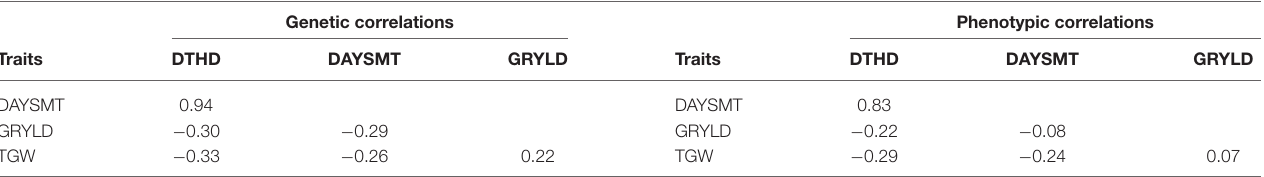
TABLE 3 | Genetic and phenotypic correlations in agronomic important traits. Genetic correlations Phenotypic correlations Traits DTHD DAYSMT GRYLD Traits DTHD DAYSMT